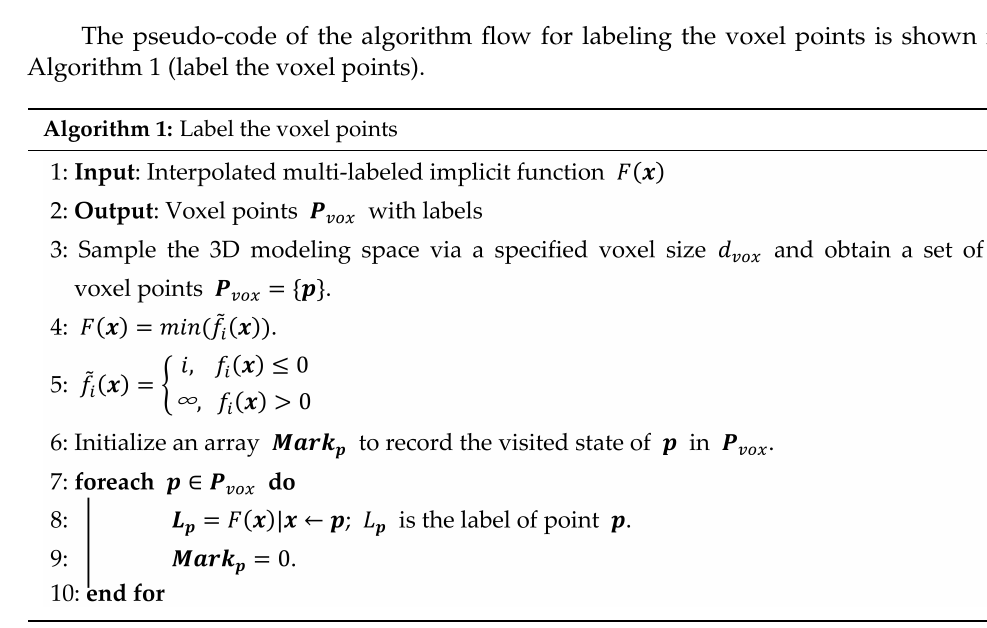
Figure 5. Strategies for repairing overlapping defects. ( a ) Original two geological bodies. ( b ) Red model with a higher priority. ( c ) Green model with a higher priority.